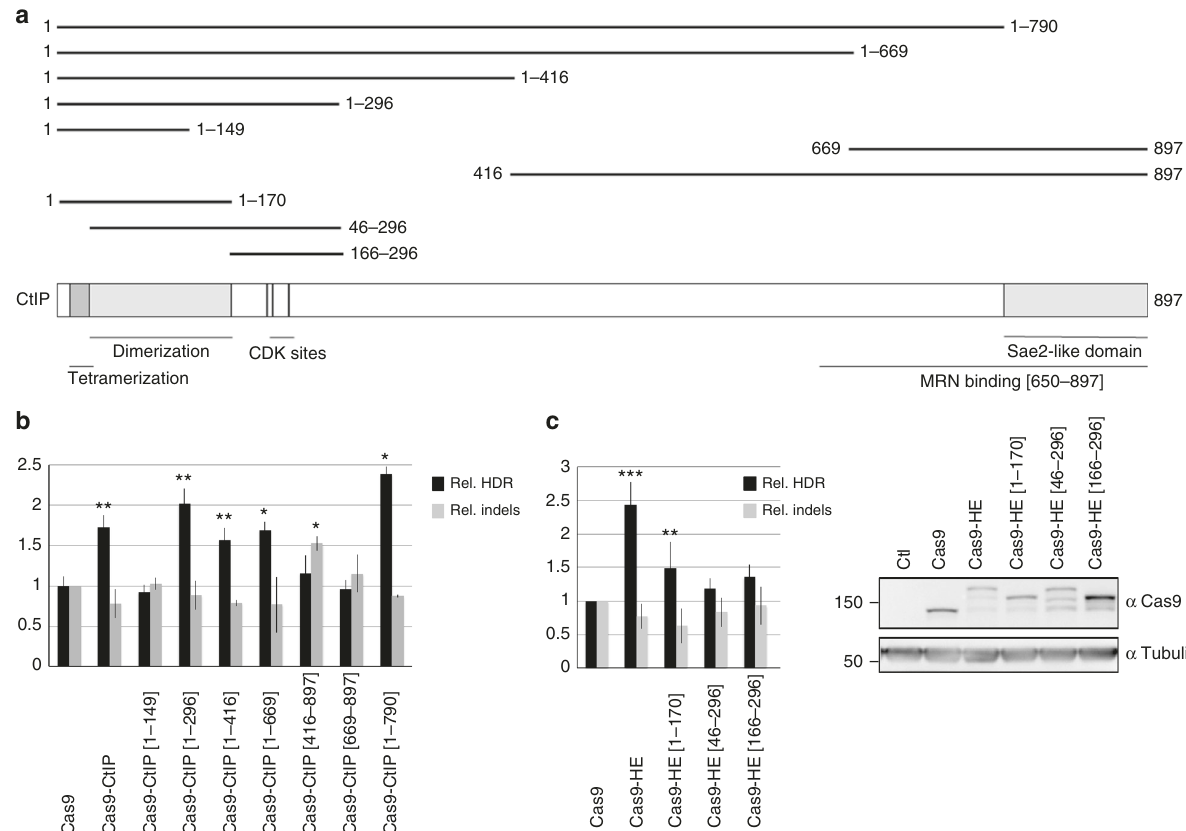
Fig. 2 Identi fi cation of the “ HDR-enhancer ” (HE) domain of CtIP. a Schematic diagram of CtIP protein showing the different truncated CtIP proteins that have been fused to Cas9 and tested for their ability to stimulate HDR. Various sequence features of CtIP, including tetramerization and dimerization domains, and CDK phosphorylation sites S233, T245, and S276, are indicated. b Identi fi cation of a domain of CtIP, called HE, spanning aa 1 to 296, which is able to stimulate HDR when fused to Cas9. Human RG37 fi broblasts were transfected with the indicated plasmids expressing Cas9 or Cas9 – CtIP derivatives, T2 guide RNA plasmid, and GFP transgene donor with homology arms to the targeted AAVS1 locus. Expression of fusion proteins was examined by western blot (Supplementary Fig. 1). Data are from four independent experiments. Error bars indicate standard deviation. c Functional analysis of HE domain. HEK293 cells were transfected with the indicated Cas9 plasmids, T2 guide RNA, and GFP transgene donor with homology arms to the